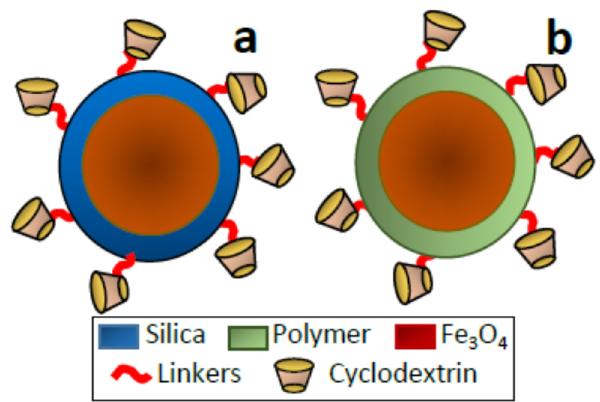
Figure 5. Schematic representation of the structures CD-modified core-shell nanoparticles ( a ) silica-coated magnetic nanoparticles and ( b ) polymer-coated magnetic nanoparticles.